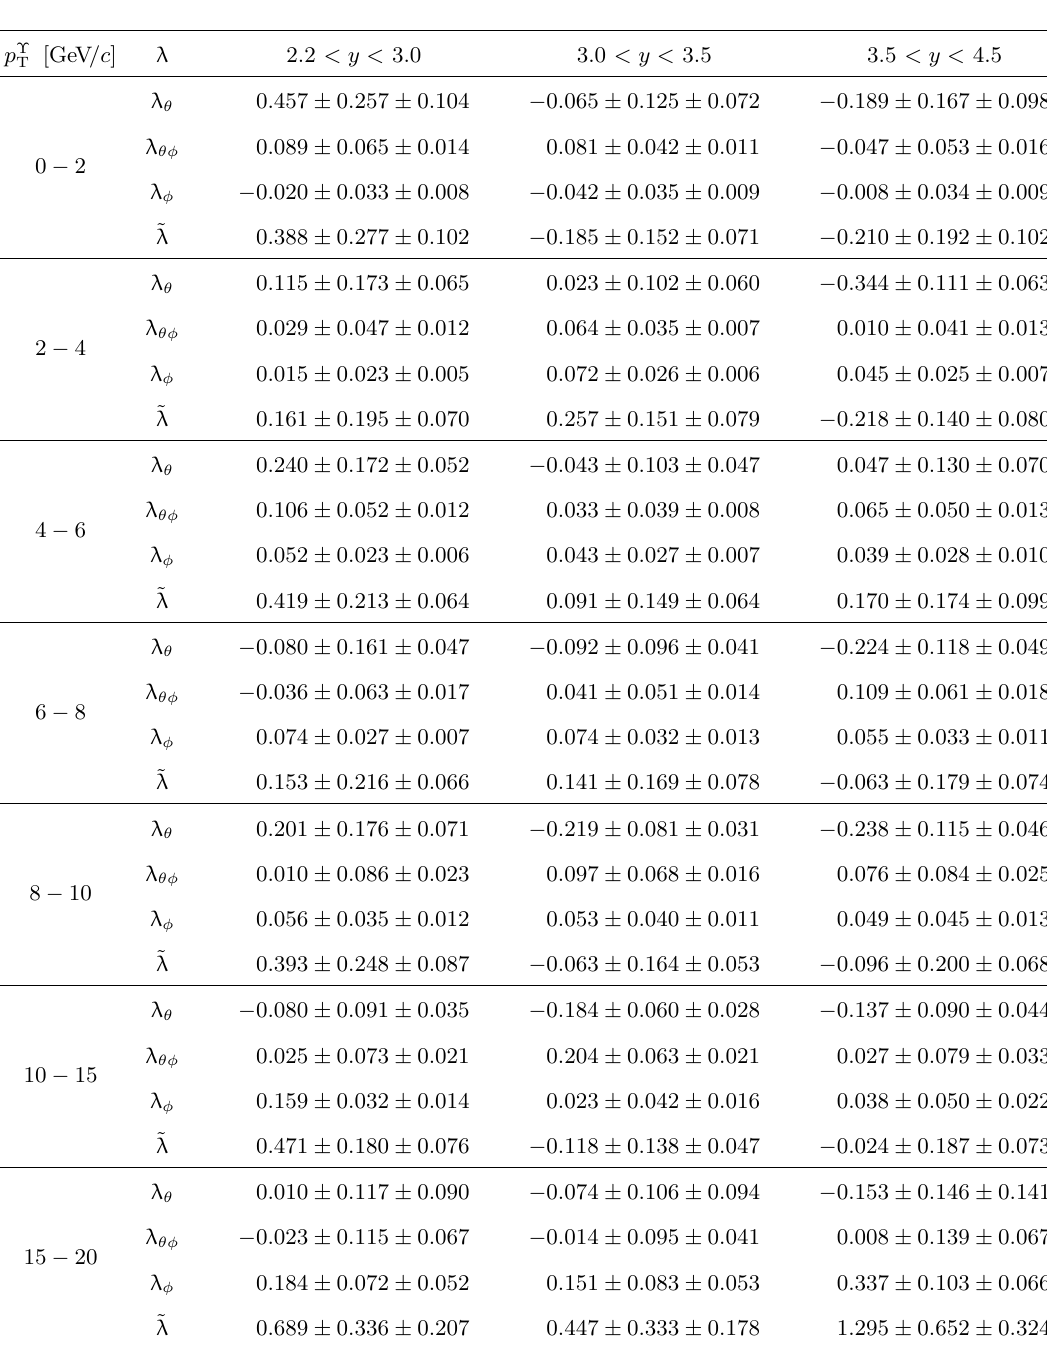
Table 22 . Values of (cid:21) (cid:18) , (cid:21) (cid:18)(cid:30) , (cid:21) (cid:30) and ~ (cid:21) measured in the CS frame for the (cid:7)(3S) produced at p s = 7 TeV. The (cid:12)rst uncertainty is statistical and the second systematic.